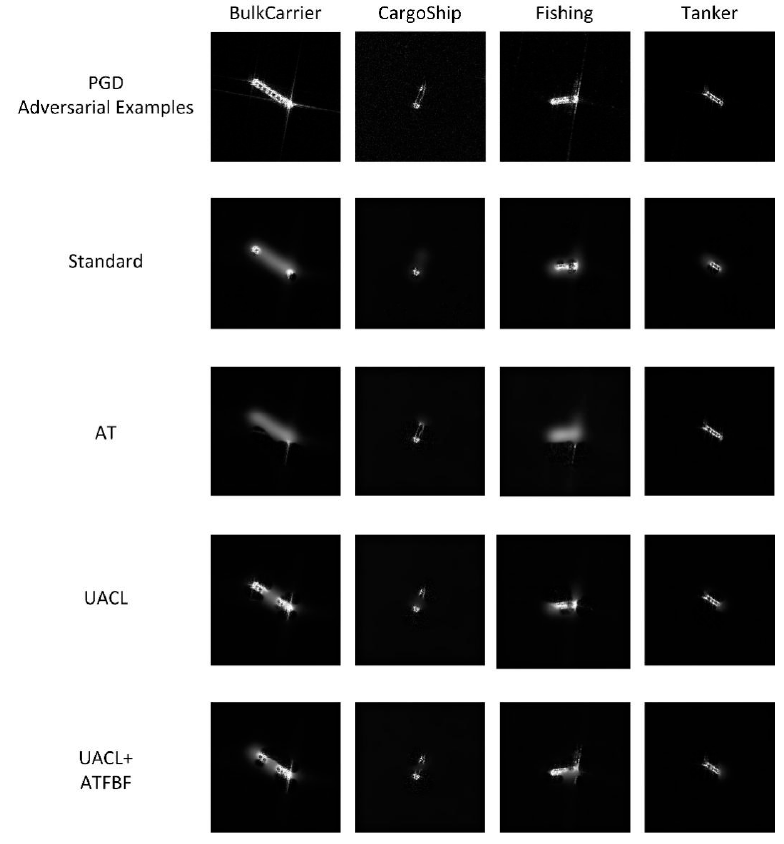
Figure 16. Extremal perturbations images of FUSAR-Ship model in the classification of adversarial examples.